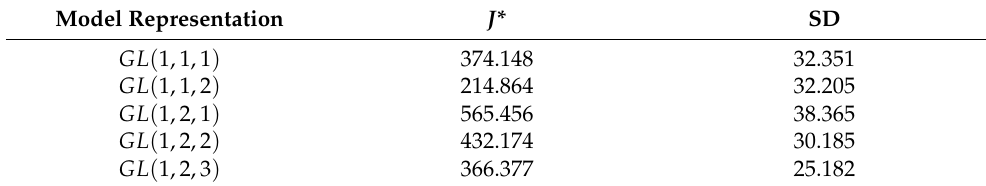
Table 2. Optimal profit and standard deviation values for the particular cases of the GL growth model in Section 2.1. Values are in millions of US dollars. SD represents standard